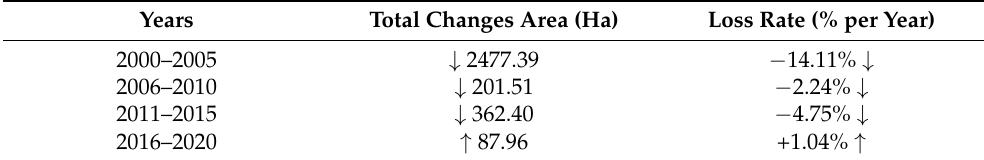
Table 7. Mangrove loss rate percentage per year every 5 years. The “ ↓ ” symbol represents the loss trend, while the “ ↑ ” symbol represents the gain trend. Years Total Changes Area